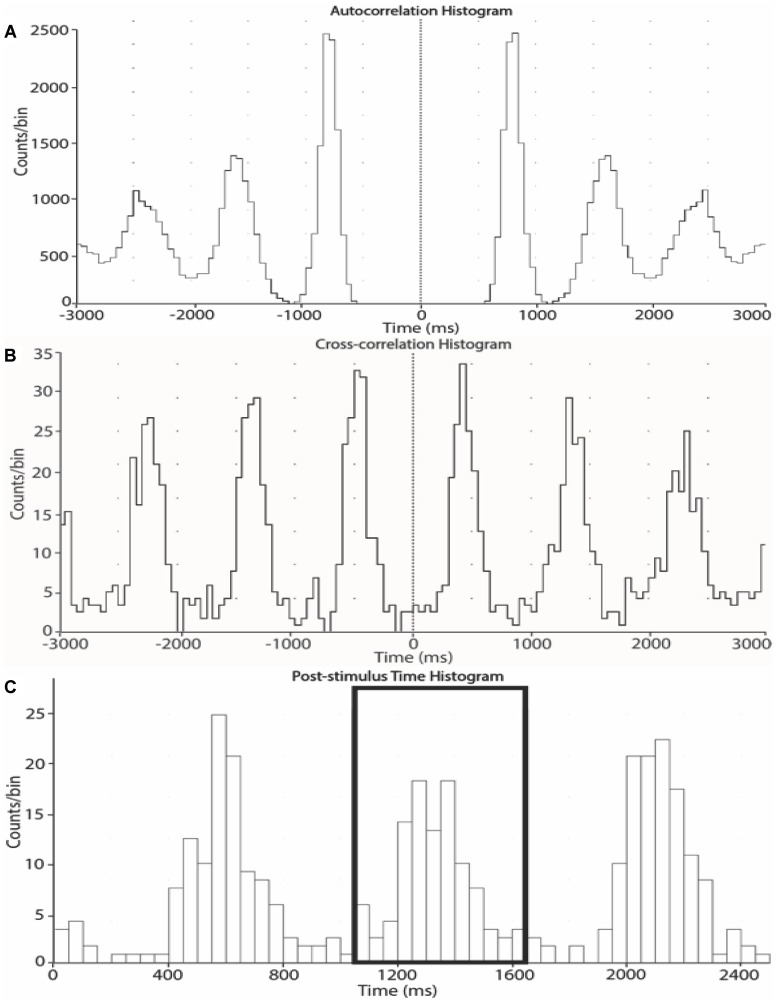
Autocorrelation (A), cross-correlation (B) and post-stimulus time (C) histograms from one subject. The histograms were generated from 1-min epochs to measure the timing of neural spikes relative to cardiac beats and count the number of sympathetic spikes during each epoch.